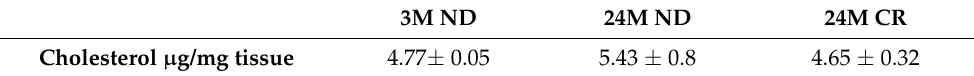
Table 2. Cholesterol content in the